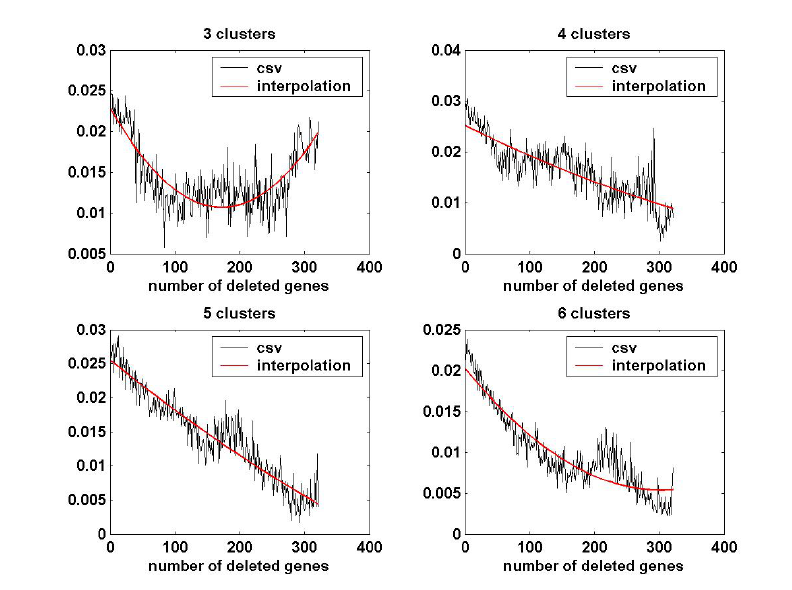
Figure 2: CSV of fission yeast data